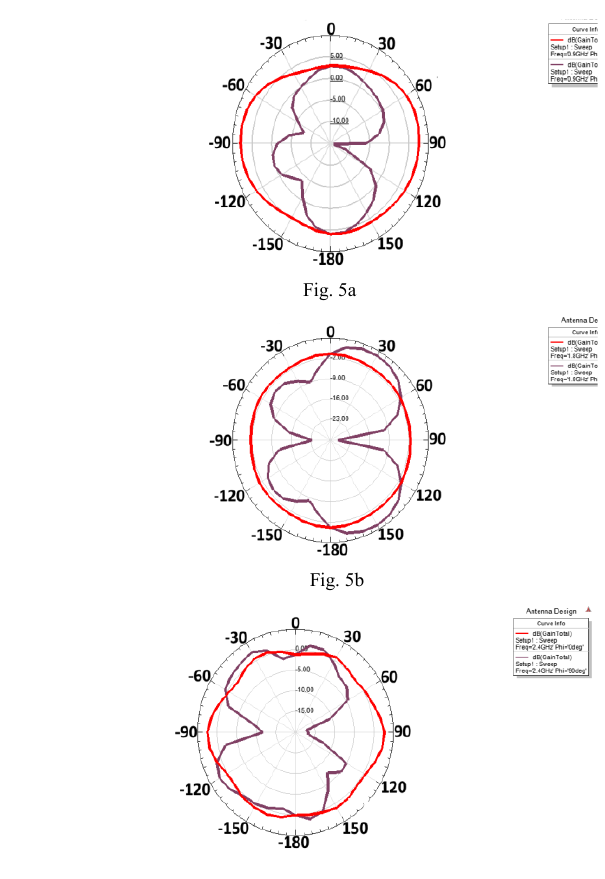
Figure 4: VSWR plot of